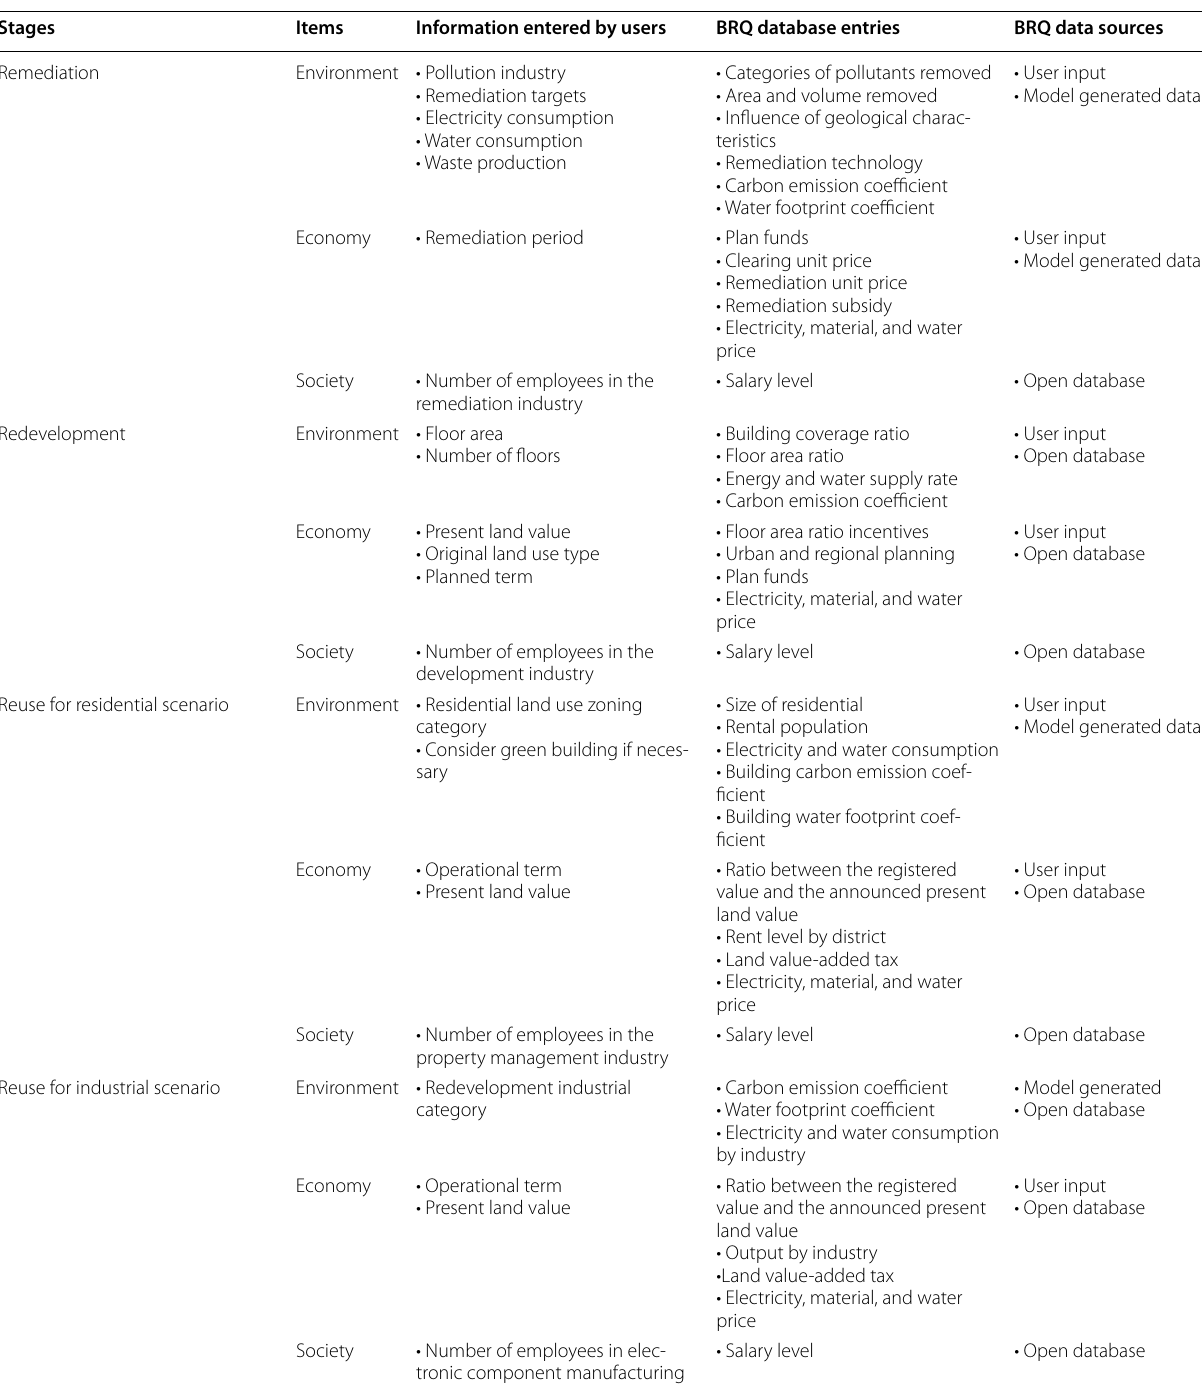
Table 4 Data sources and entries for the BRQ model